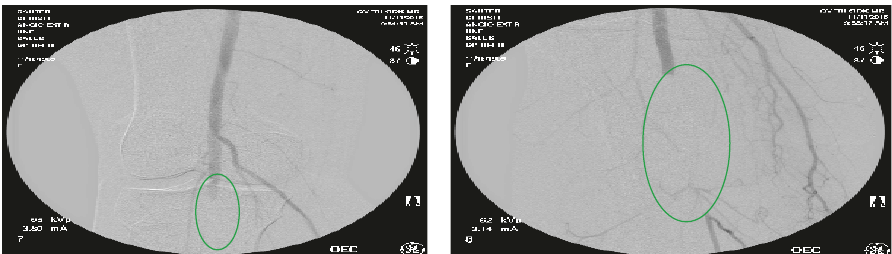
Figure 1: Intraoperative right leg angiogram showing below the knee filling defect at the right popliteal artery extending beyond the tibioperoneal trunk which likely represents a